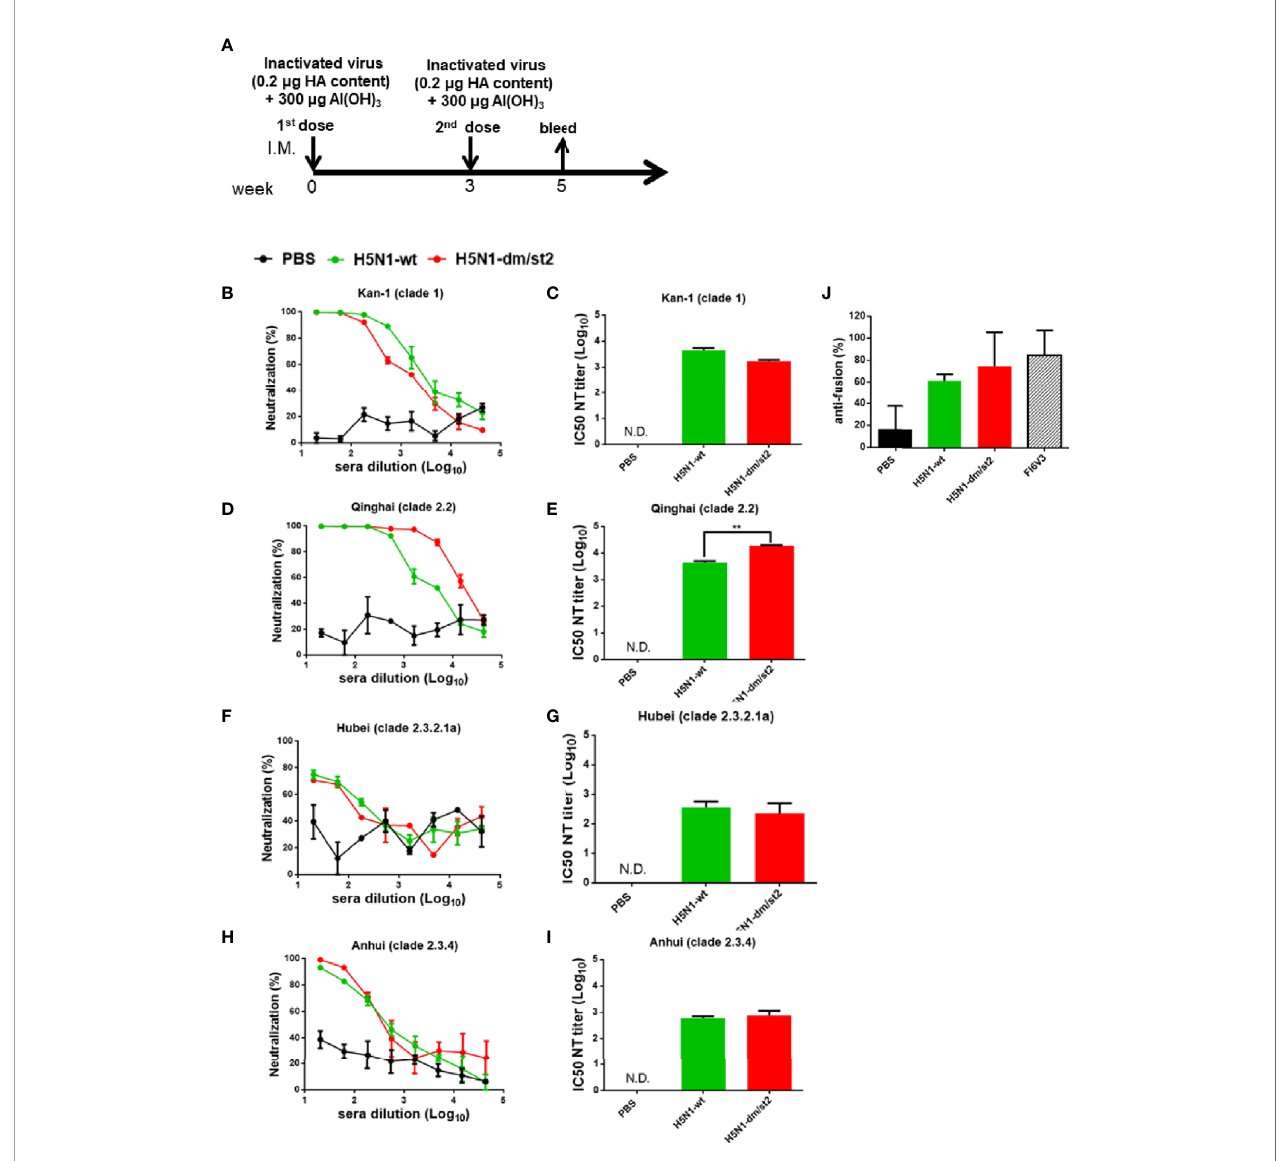
FIGURE 8 | Immunizations with inactivated RG H5N1-wt and RG H5N1-dm/st2 viruses formulated with alum adjuvant. (A) Inactivated RG H5N1-wt and RG H5N1- dm/st2 viruses were immunized intramuscularly for two doses in a three-week interval. Each dose contained 0.2 m g HA content formulated with 300 m g alumn adjuvant. Serum samples were bled at week 5 and measured for virus-neutralizing antibodies against various clades/subclades of H5N1 viruses. Neutralization curves and their corresponding IC50 titers were plotted against (B, C) KAN-1(clade 1), (D, E) Qinghai (clade 2.2), (F, G) Hubei (clade 2.3.2.1a), and (H, I) Anhui (clade 2.3.4). (J) HA stem-mediated fusion inhibition activity of antisera were determined using a luciferase-based cell-cell fusion assay. Stem-binding mAb FI6v3 was used as a positive control. Data were analyzed using one-way ANOVA. (**p <